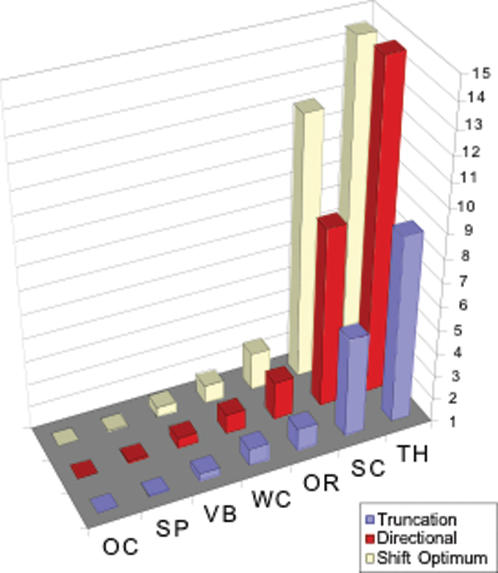
Hsp90-buffered variation contributed to predicted selection responses.Fold-increase in the predicted response to truncation, directional or stabilizing selection of the ‘populations’ of 9 RI line genotypes in the P582i mutant relative to equivalent ‘populations’ of genotypes in the Sami control flies (Table 5).